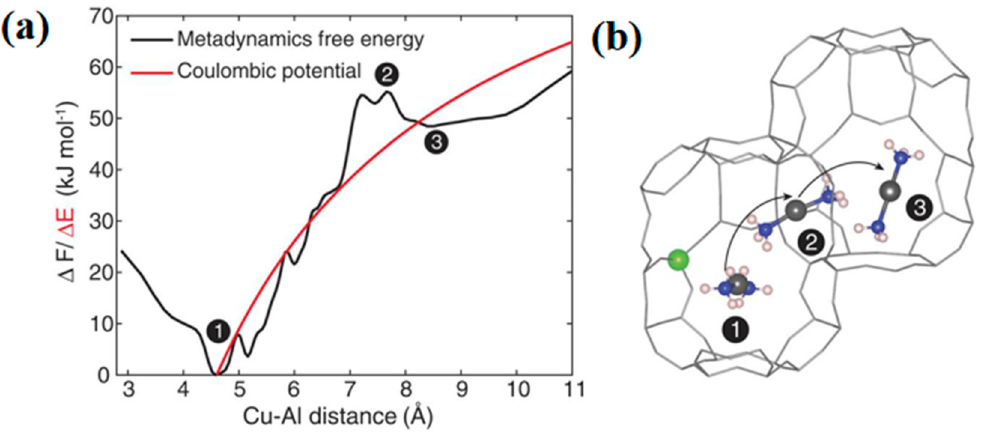
Figure 3. Simulated Cu + (NH 3 ) 2 diffusion up to 11 Å from charge-compensating Al: ( a ) the meta-dynamics-computed free energy at 473 K of Cu + (NH 3 ) 2 in the 72-T site CHA supercell versus Cu–Al distance and ( b ) the corresponding representative Cu + (NH 3 ) 2 configurations from the trajectories in ( a ). Reproduced with permission from [56], copyright American Association for the Advancement of Science, 2017.